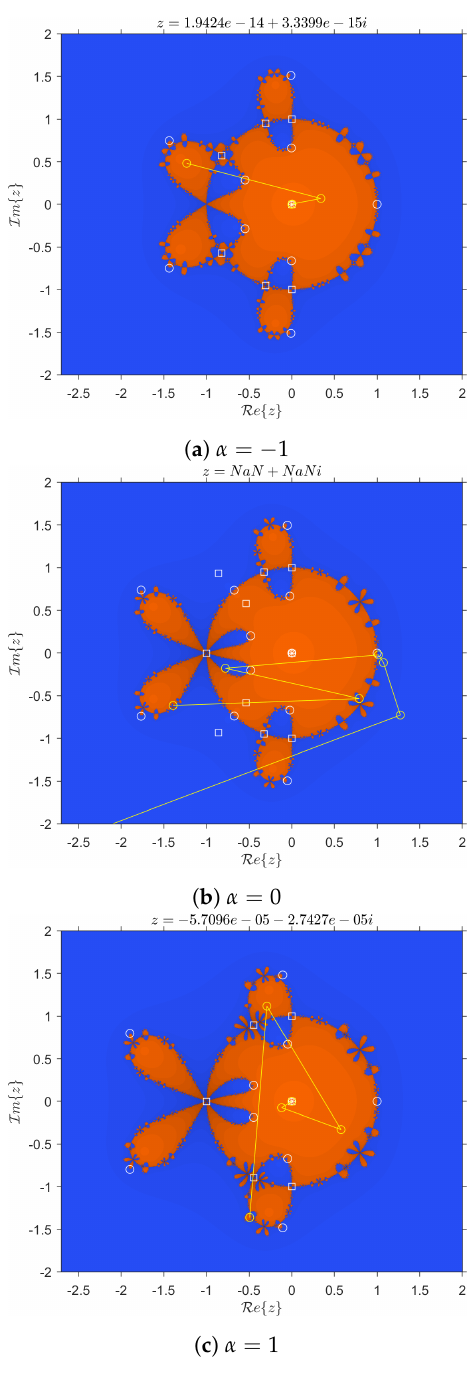
Figure 4. Dynamical planes for methods inside the stability region (basin of attraction of 0 in orange color; in blue color, the basin of ∞